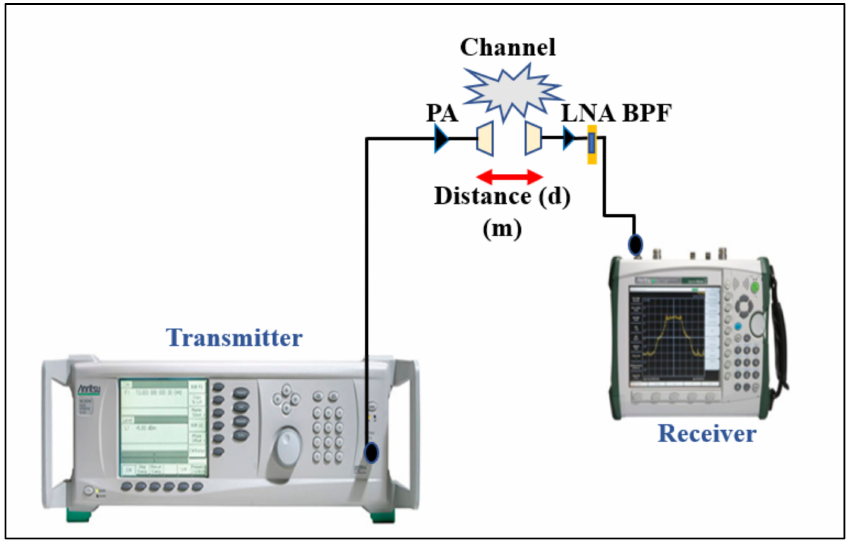
Figure 12. Measurement equipment setup for the path loss (LNA: low noise amplifier; BPF: band pass filter; PA: power